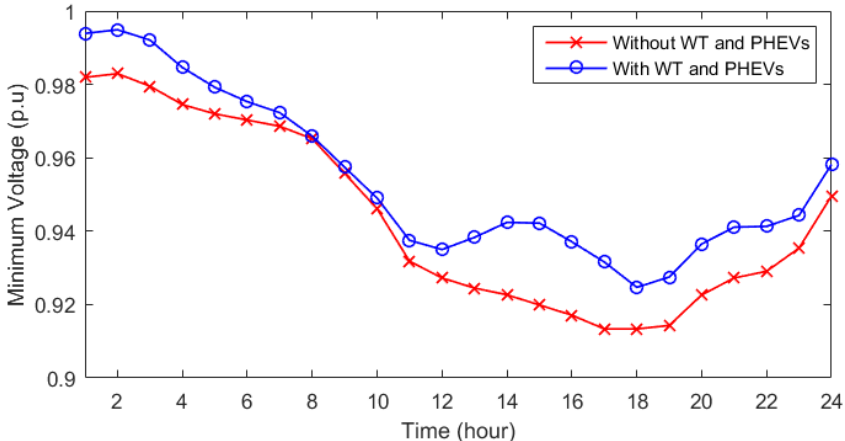
Figure 9. Minimum voltage of a 33-bus distribution network with and without WT and PHEVs using the IGJO for 24 h.